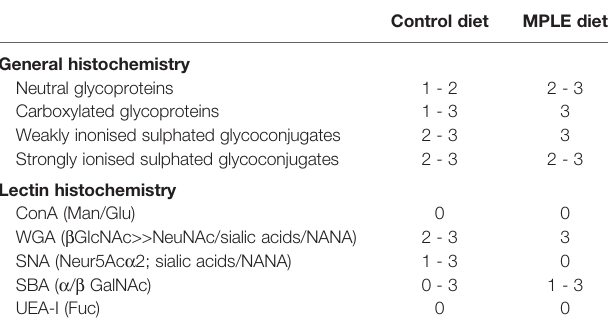
TABLE 2 | Histochemical characteristics and lectin af fi nity of mucins produced by goblet cells from anterior intestine of gilthead seabream ( Sparus aurata ) fed the control and this basal diet supplemented with a medicinal plant leaf extract (MPLE) obtained from sage ( Salvia of fi cinalis ) and lemon verbena ( Lippia citriodora